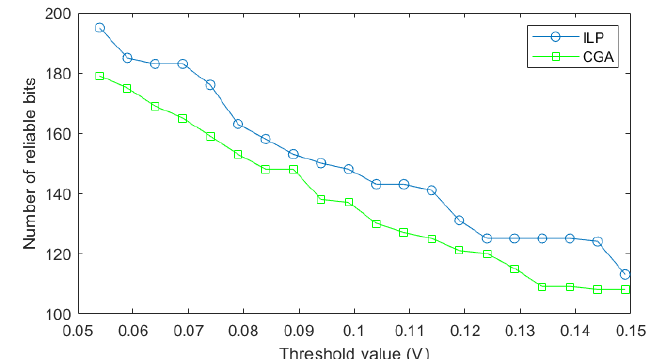
Figure 6. Reliable bits generated by ILP and CGA from DiffC-PUF.